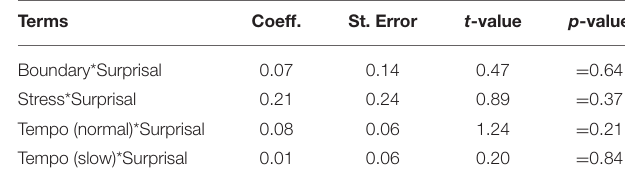
TABLE 5 | Interaction model of segmental duration: interaction of surprisal with prosodic factors. Terms Coeff.